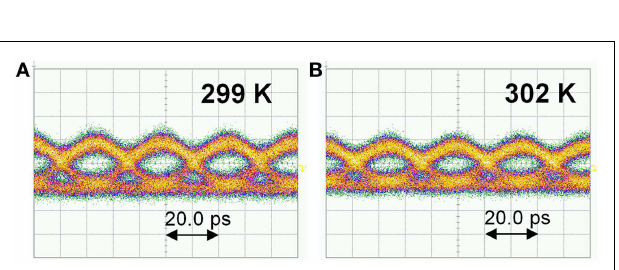
FIGURE 7 | Eye diagrams of Si–SiN-waveguide DL MZI at (A) 299 and (B) 302K .